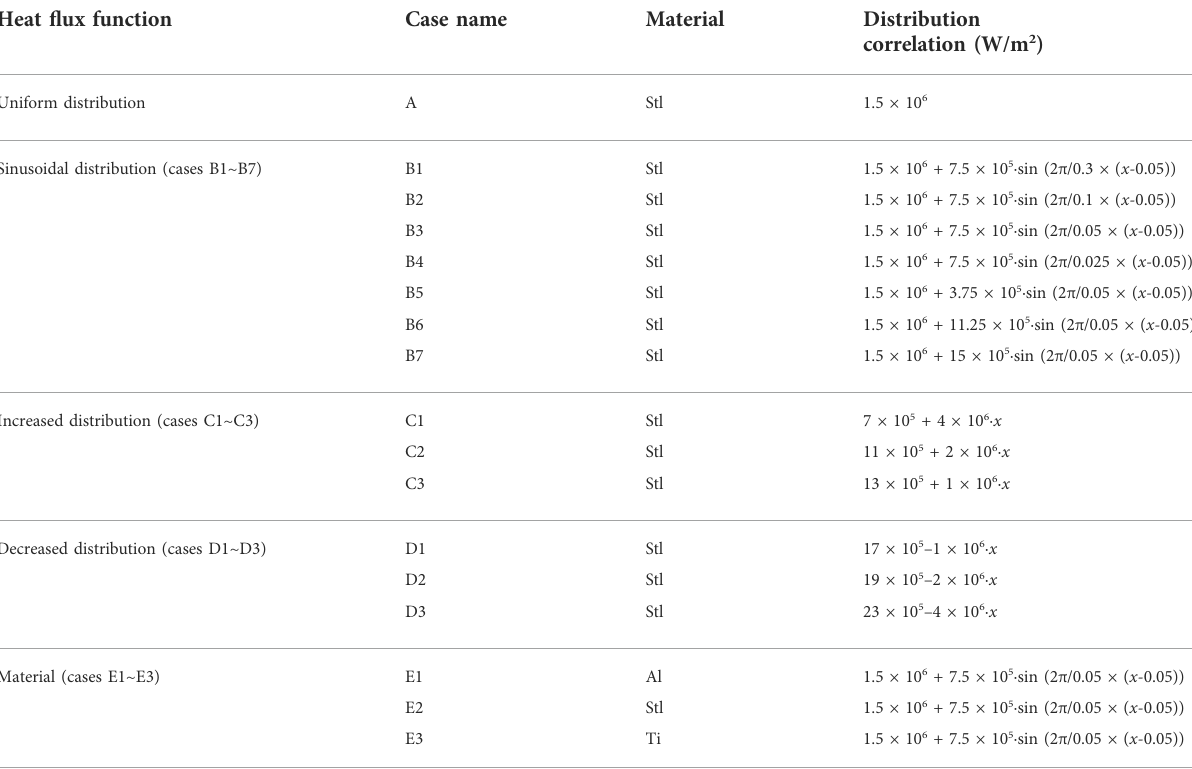
TABLE 1 Wall material and heat fl ux density of all the